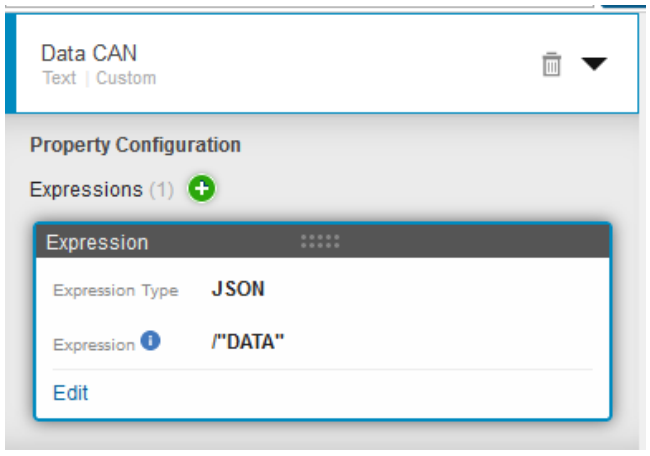
Figure 3. An example of property created on QRadar to obtain the value of key “DATA”.